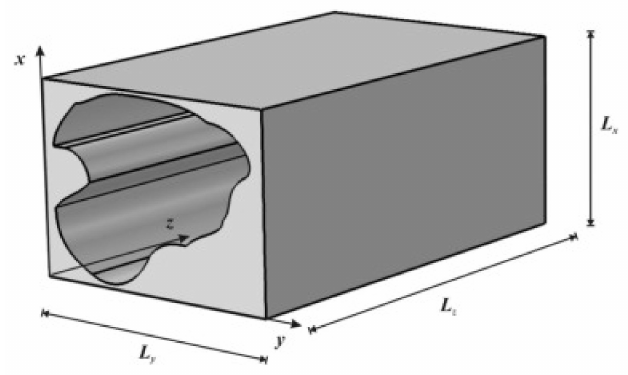
Figure 9. Irregular channel [86] © Elsevier,